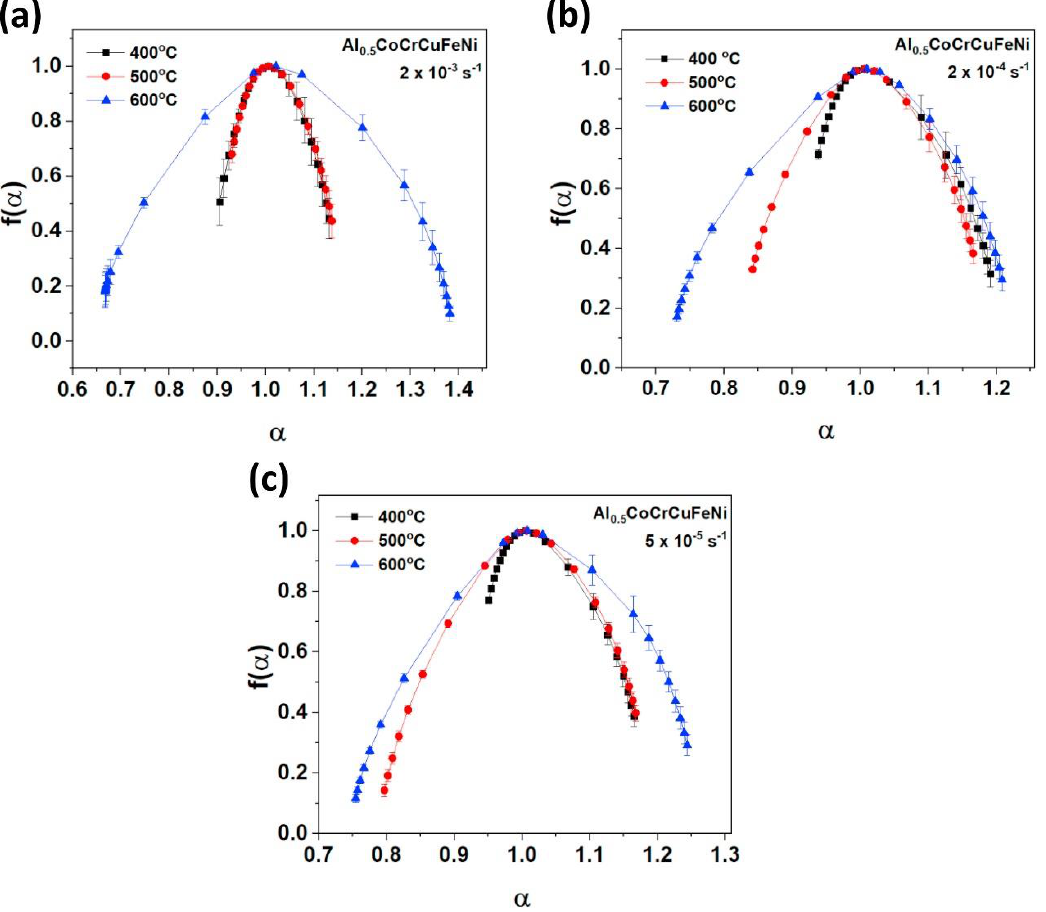
Figure 16. The multifractal spectra (f(α) vs. α) for the Al 0.5 CoCrCuFeNi HEA samples tested at strain rates of ( a ) 2 × 10 −3 s −1 , ( b ) 2 × 10 −4 s −1 , and ( c ) 5 × 10 −5 s −1 and temperatures of 400–600 °C, where the sample entropy was plotted for scale factors ranging from 1 to 20. (Results reproduced from Reference [180] with permission.)